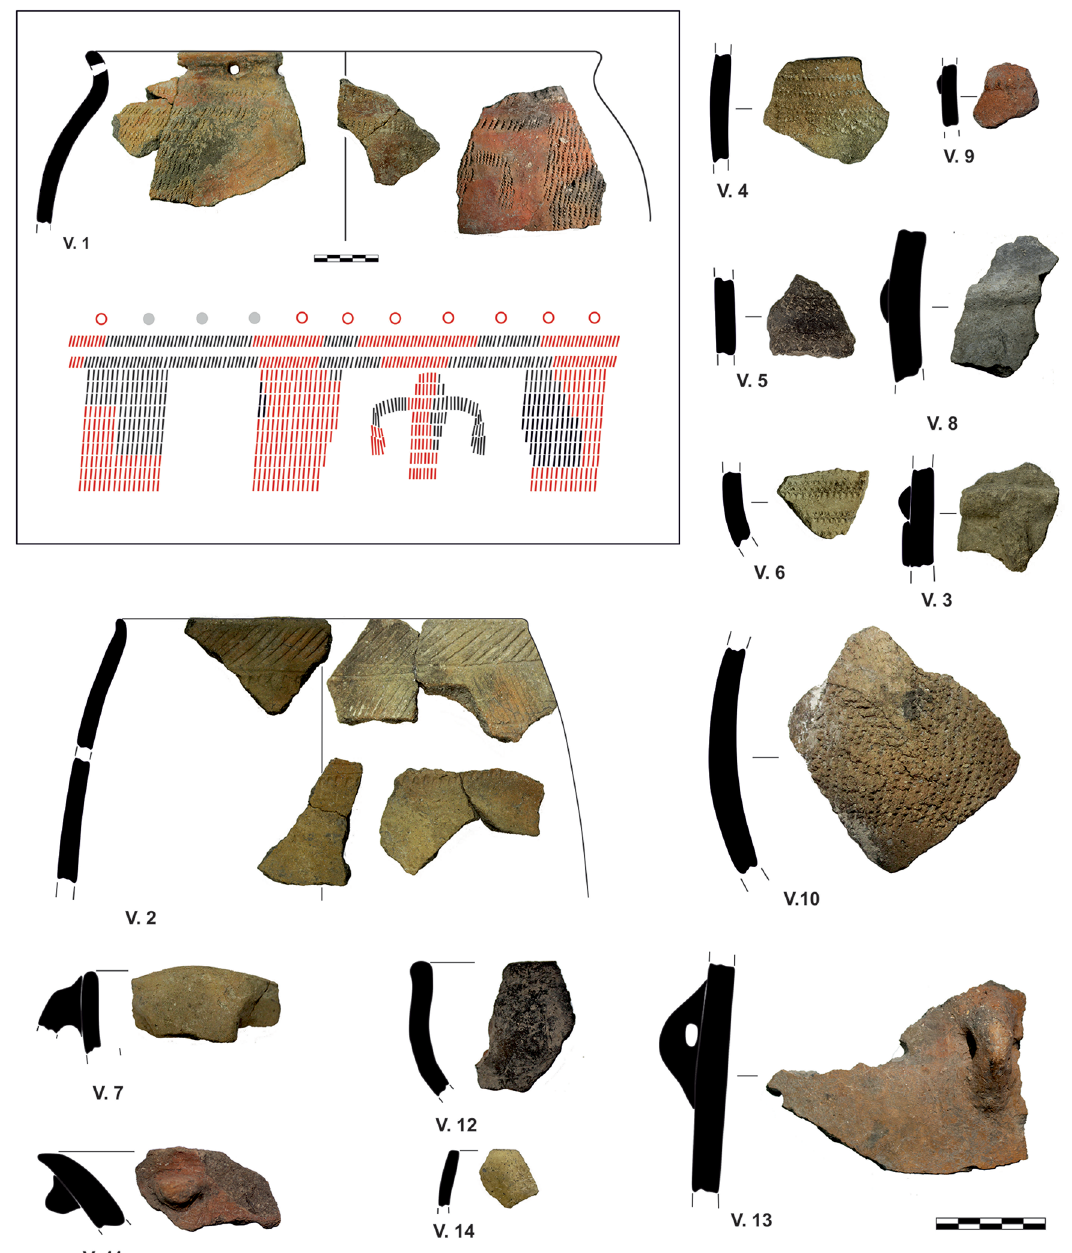
Figure 3: Individualised vessels from Penya Roja de